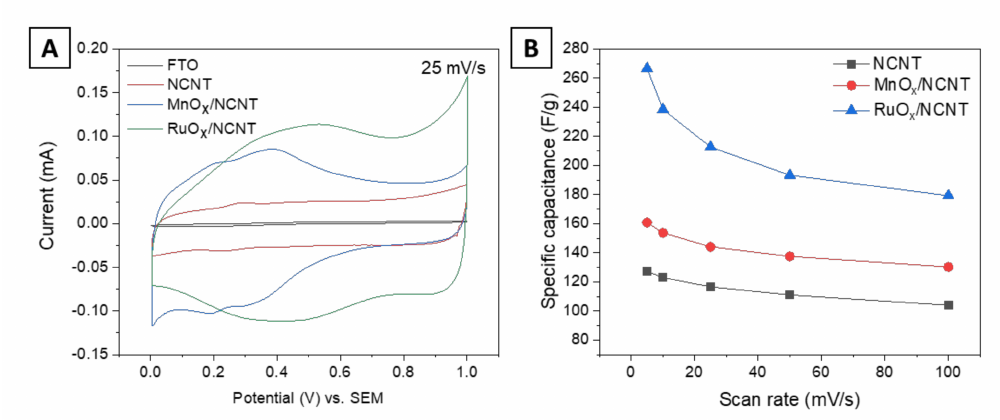
Figure 5. Electrochemical characterization. ( A ) Cyclic voltammograms of NCNTs, MnO x /NCNT and RuO x /NCNT at a scan rate of 25 mV/s. ( B ) Gravimetric specific capacitance vs. scan rate for NCNTs, MnO x /NCNT and RuO x /NCNT.